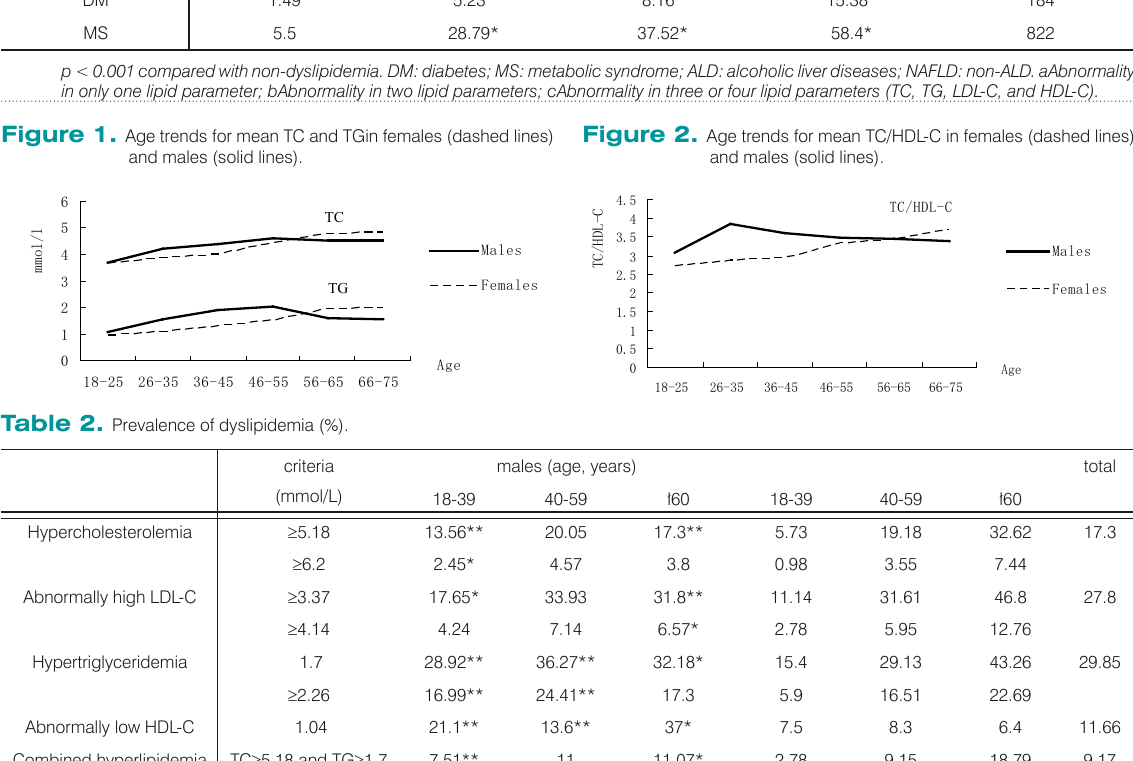
Figure 1. Age trends for mean TC and TGin females (dashed lines) and males (solid lines).